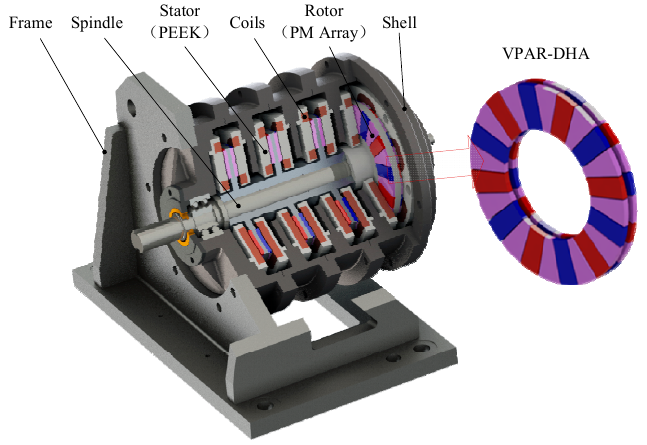
Figure 3. Structure of a proposed disk voice coil motor-based electrodynamic exciter